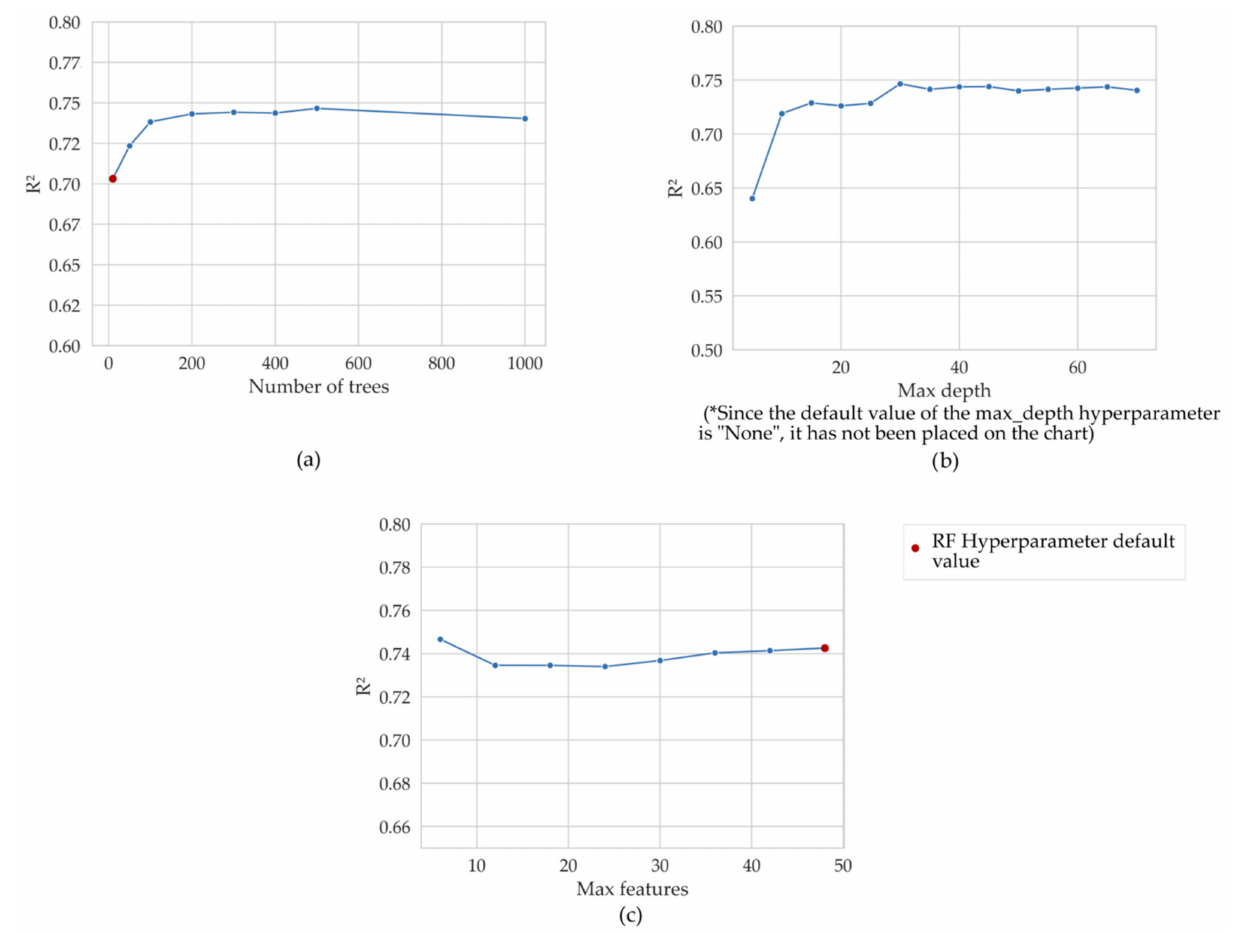
Figure 5. Evolution of the 12-h forecast model performance (R 2 ) along the different hyperparameter values in relation to ( a ) the number of trees, ( b ) maximum depth of the tree, and ( c ) maximum number of